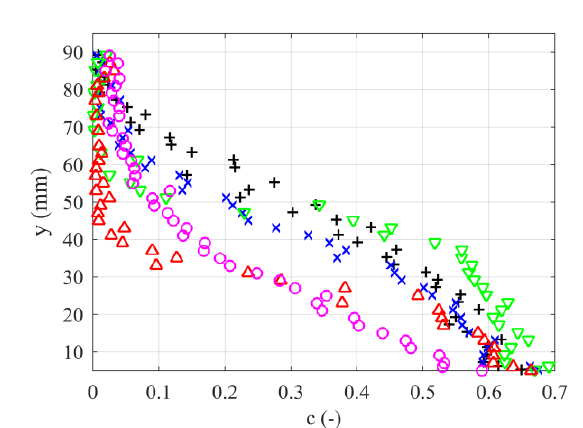
Fig. 1. Distribution of granular concentration at V m ~ 1.5 m.s -1 for flow of SP090 slurry ( C vd,max = 0.26) at different pipe inclination (descending pipe) . Legend: black = 0 deg, blue = -15 deg, green = -25 deg, red = -35 deg, magenta = -45 deg.